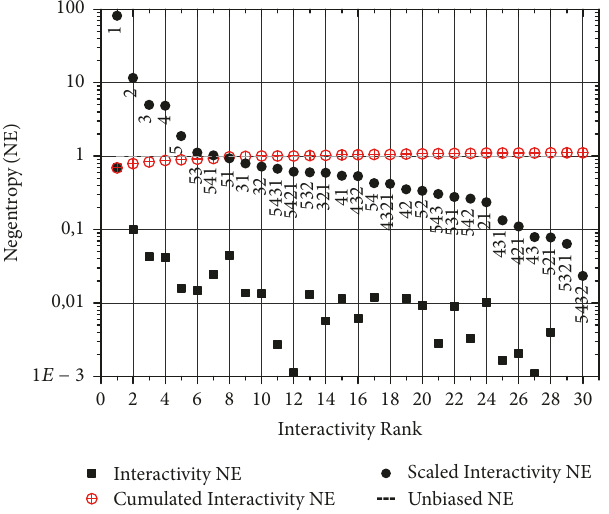
Figure 13: As in Figure 9 but for the ISA summary of SSTA data.